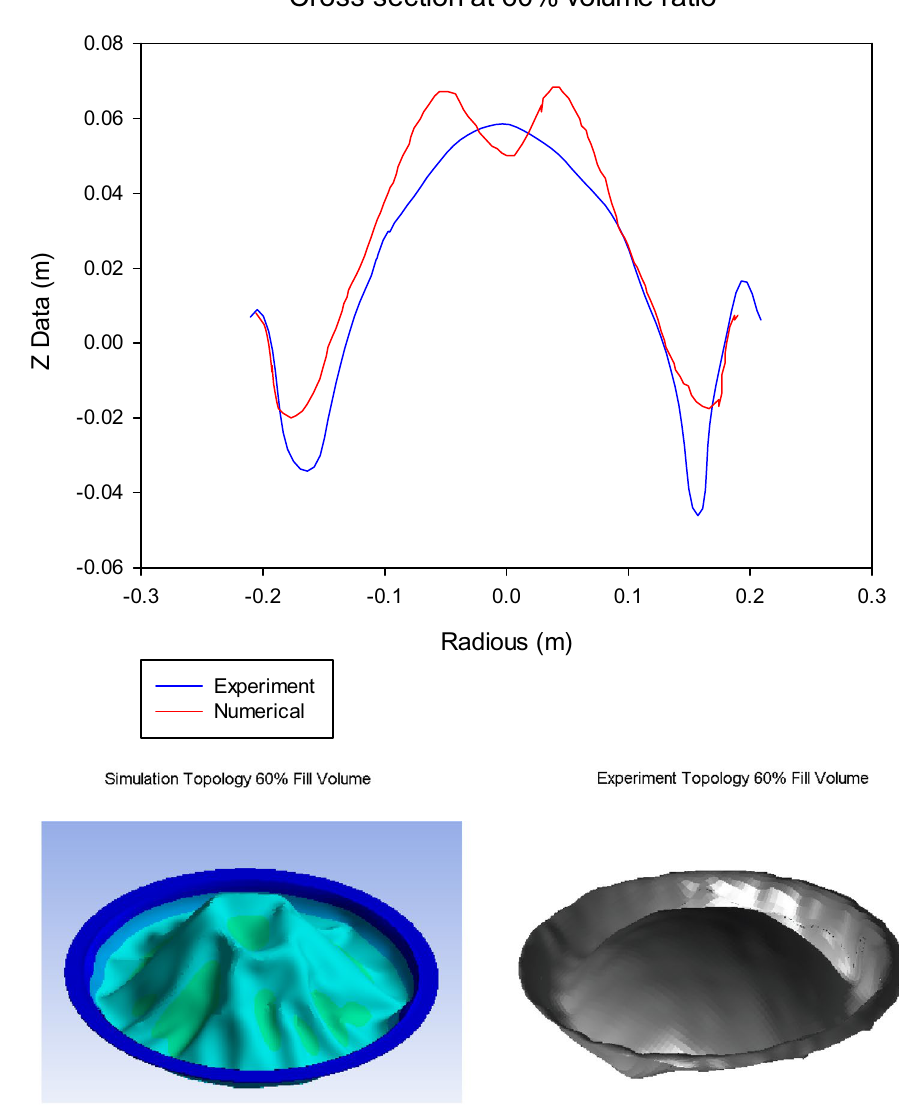
Cross section at 60% volume